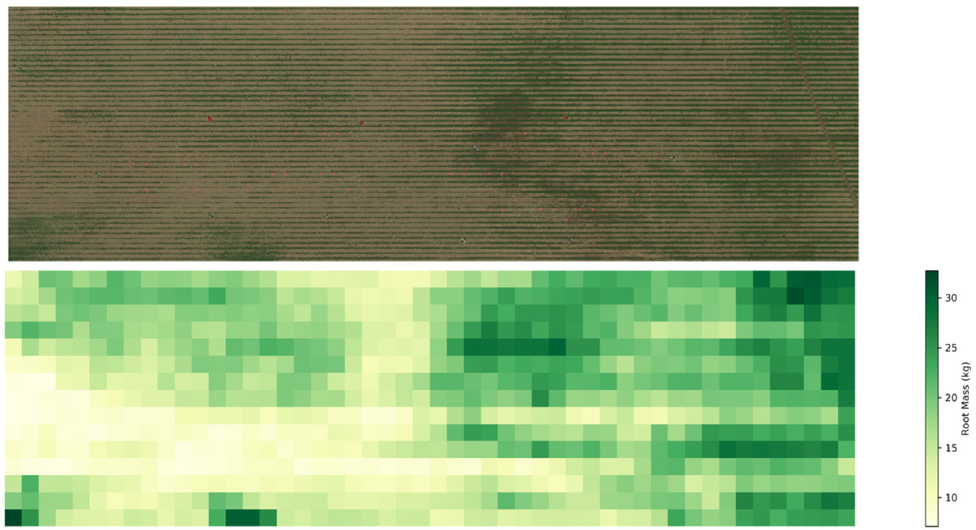
Figure 10. An evaluation of the area-augmented 2018 table beet root mass model on the independent augmented area plot imagery, taken on 16 July 2019. Since we do not have ground truth root mass data for the 2019 plots, we applied the model to the whole field for an approximate assessment. An RGB composite ( top ) of a large portion of the 2019 field serves as context for the 2 × 2 m grid of the field with the table beet root mass model.